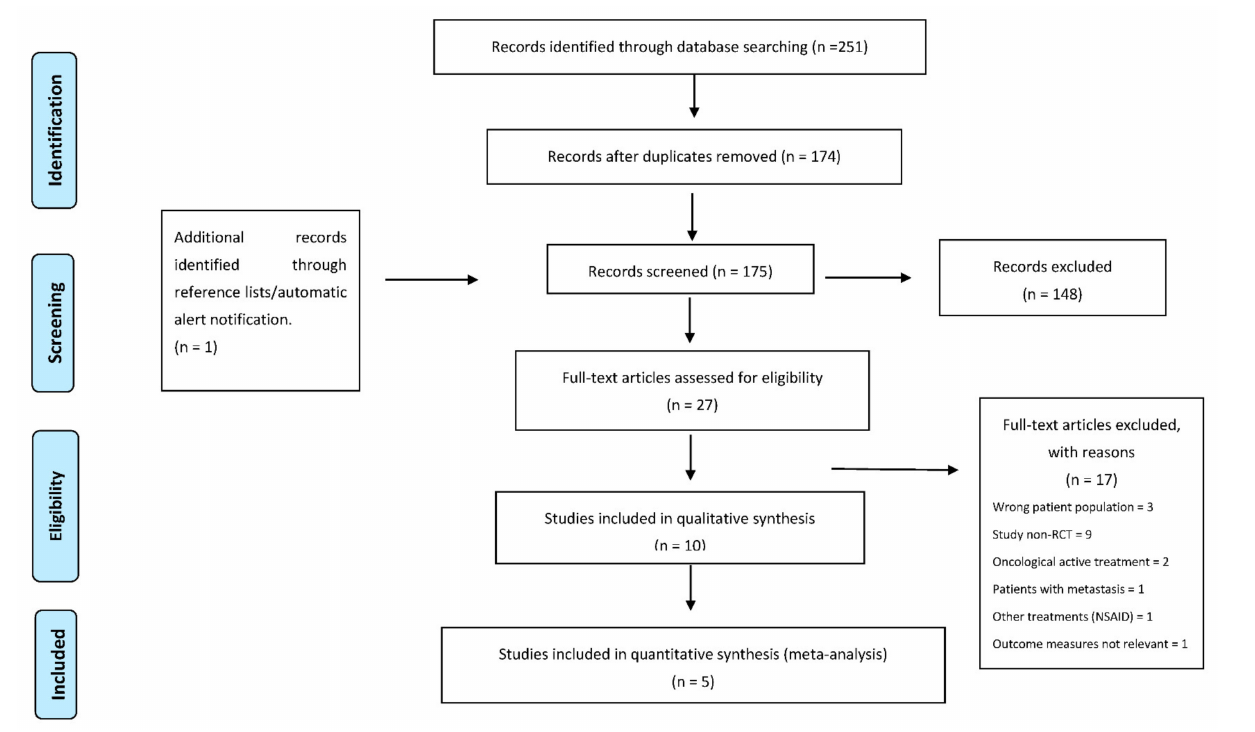
Figure 1. Flowchart of search results and filtering of the documents selected in this